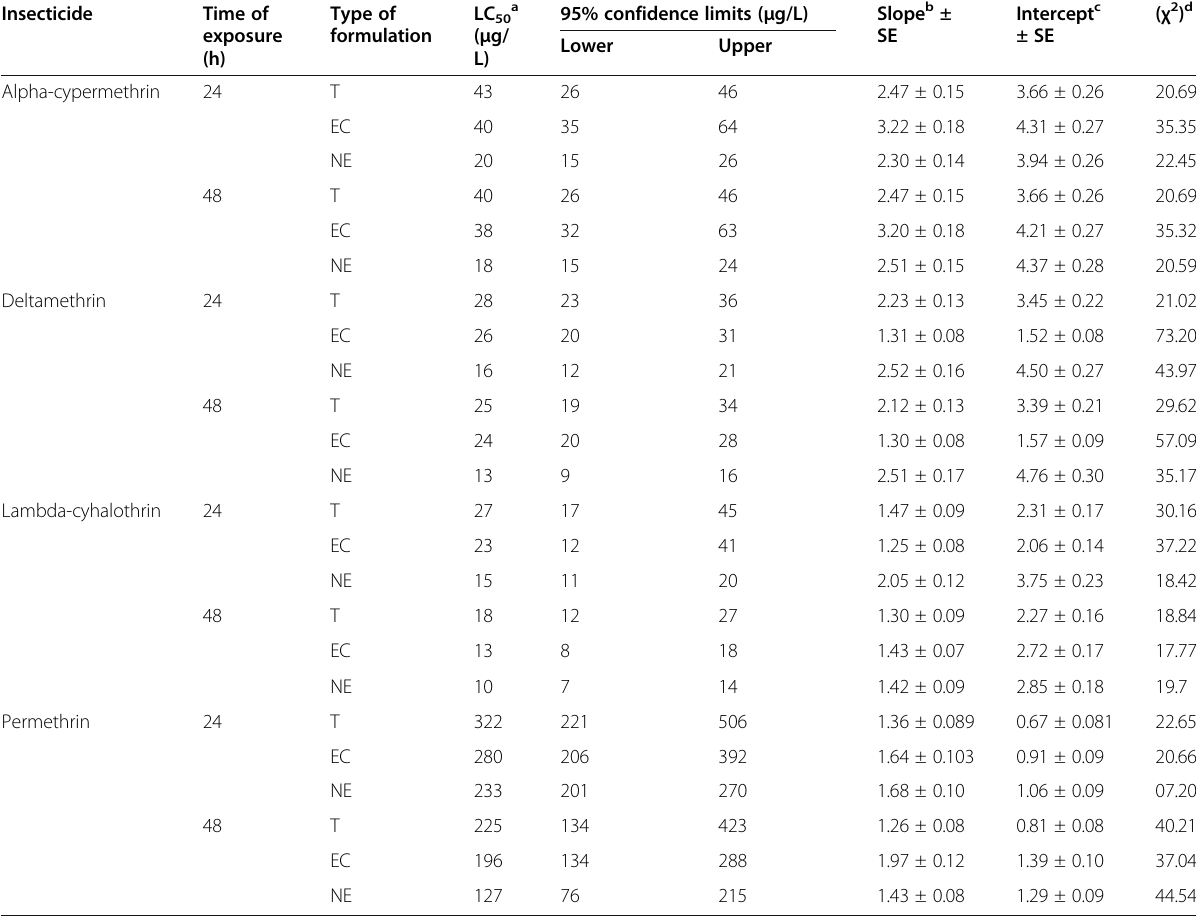
Table 2 Larvicidal activity of the technical, EC, and nanoemulsion of alpha-cypermethrin, deltamethrin, lambda-cyhalothrin, and permethrin against C. pipiens